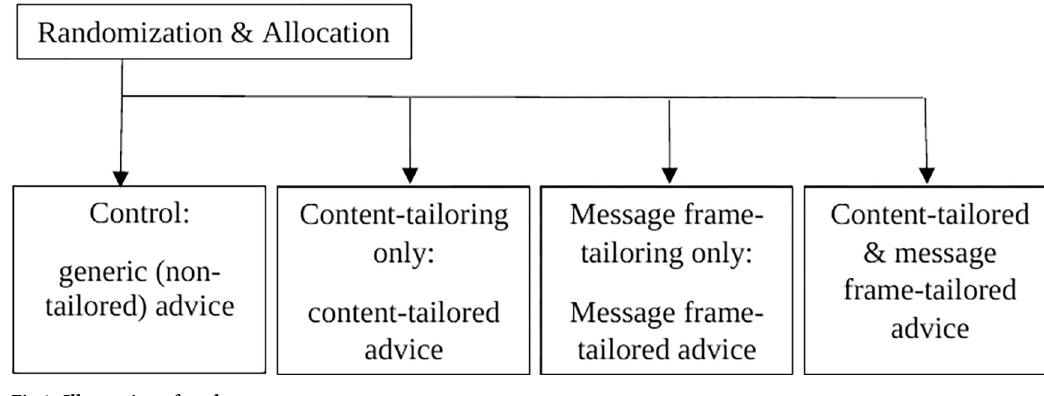
Fig 1. Illustration of study